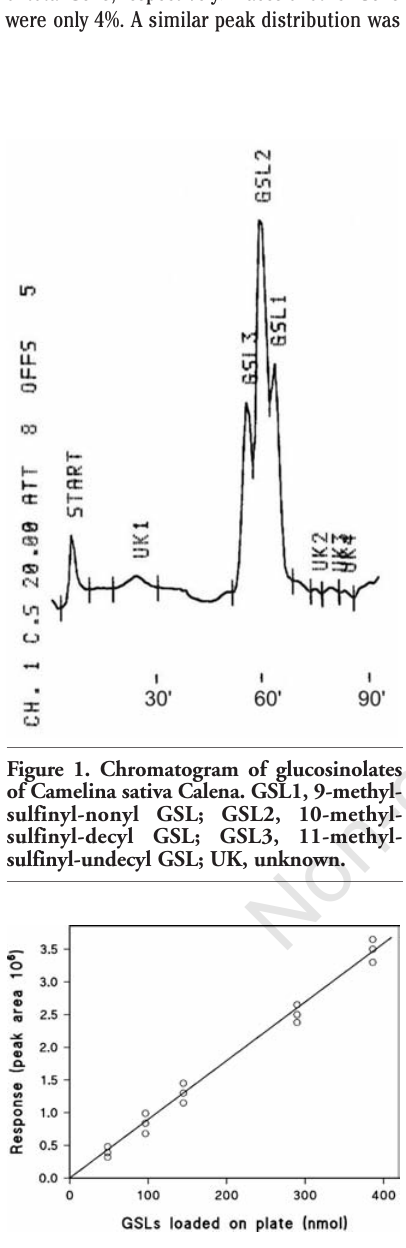
Figure 2. Calibration curve for GSLs: y , densitometer response (peak area); x , amount of desulfo-sinigrin loaded on plate (nmol). R 2 =0.989.